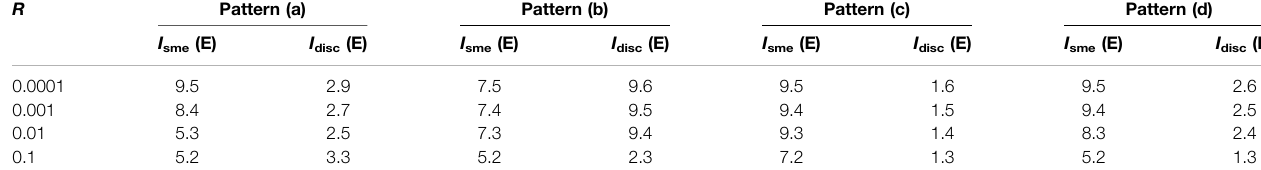
TABLE 1 | Condition numbers of element stiffness matrix corresponding to four partition patterns obtained using two integration methods.